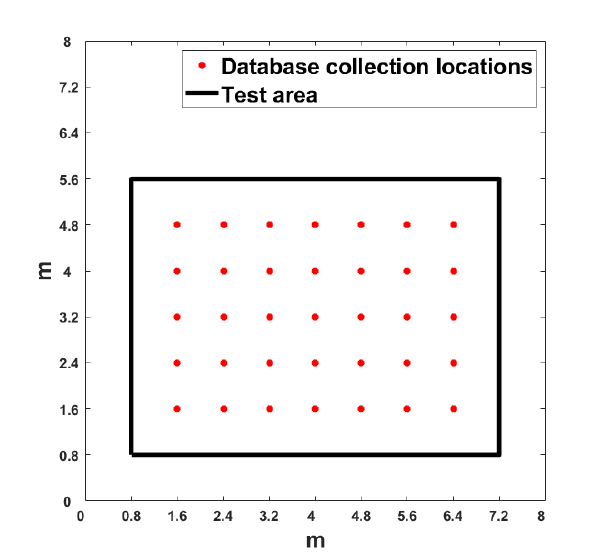
Figure 8. The location of the sampling point and the test area.